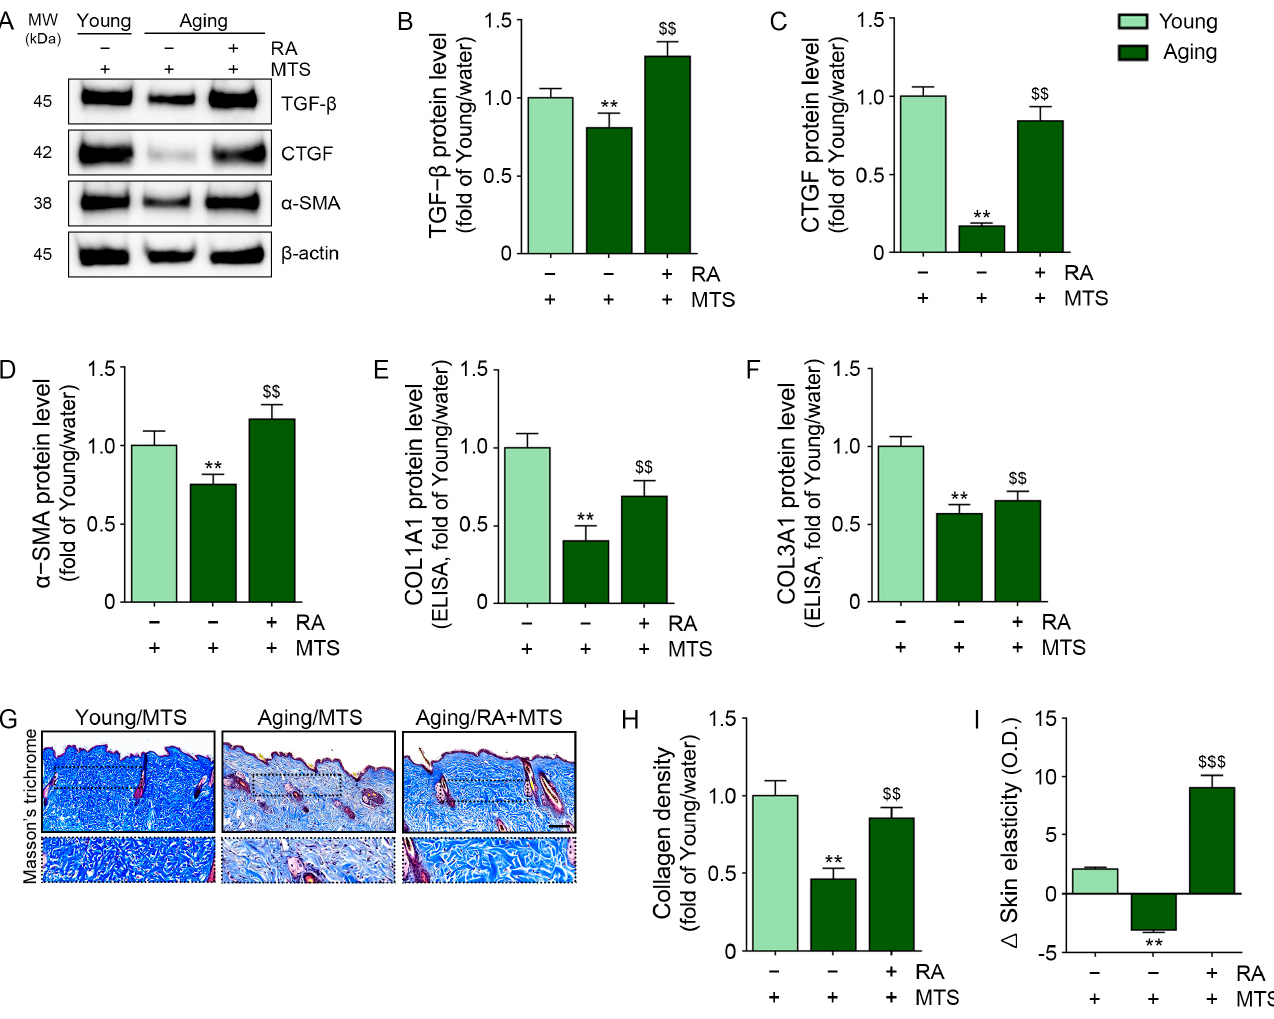
Figure 6. RA treatment increased collagen fiber levels in aged mouse skin. ( A – D ) TGF- β , CTGF, and α -SMA expression were confirmed by western blotting. The expression levels of TGF- β ( B ), CTGF ( C ), and α -SMA ( D ) were decreased in aged mouse skin but increased by RA injection. ( E , F ) COLI and COLIII expression was confirmed by ELISA. The expression levels of COL1A1 ( E ) and COL3A1 ( F ) were decreased in aged mouse skin but increased by RA injection. ( G , H ) Collagen density was confirmed by Masson’s trichrome staining (scale bar = 100 µ m). ( I ) Skin elasticity was confirmed. Skin elasticity was decreased in aged mouse skin but increased by RA injection. **, p < 0.01, second bar vs. first bar; $$, p < 0.01, $$$, p < 0.001, third bar vs. second bar (Mann–Whitney U test). α -SMA; α -smooth muscle actin, COL1A1; collagen type I alpha 1, COL3A1; collagen type III alpha 1, CTGF; connective tissue growth factor, ELISA; enzyme-linked immunosorbent assay, MW; molecular weight, TGF- β ; transforming growth factor- β .